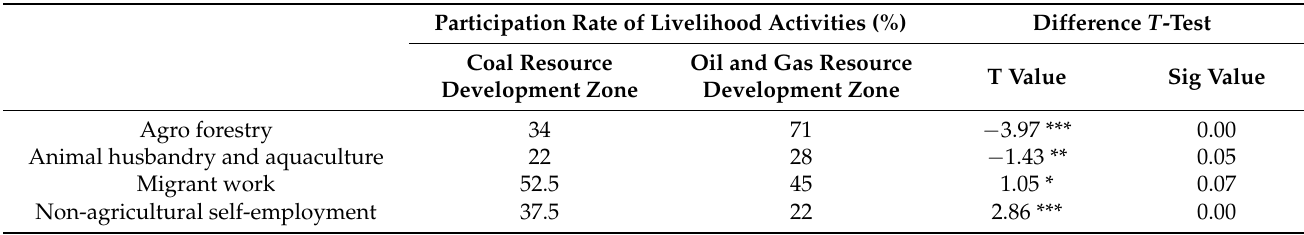
Table 4. Livelihood activities of farmers in different energy development zones.